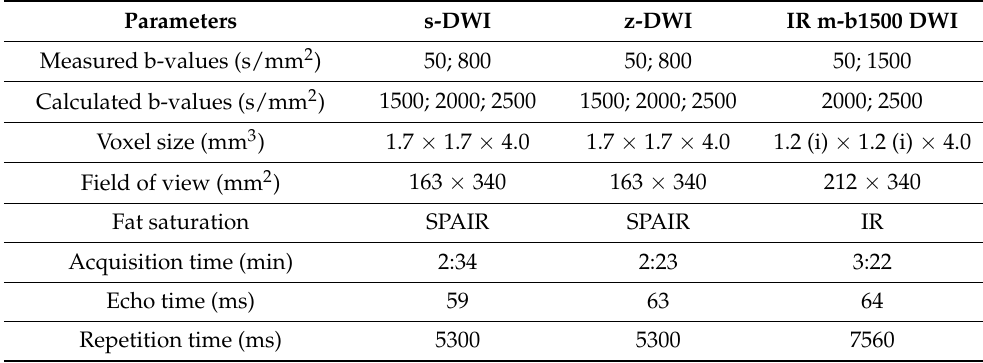
Table 1. Diffusion-weighted-imaging (DWI) protocol parameters. Parameters s-DWI z-DWI IR m-b1500 DWI Measured b-values (s/mm 2 ) 50; 800 50; 800 50; 1500 Calculated b-values (s/mm 2